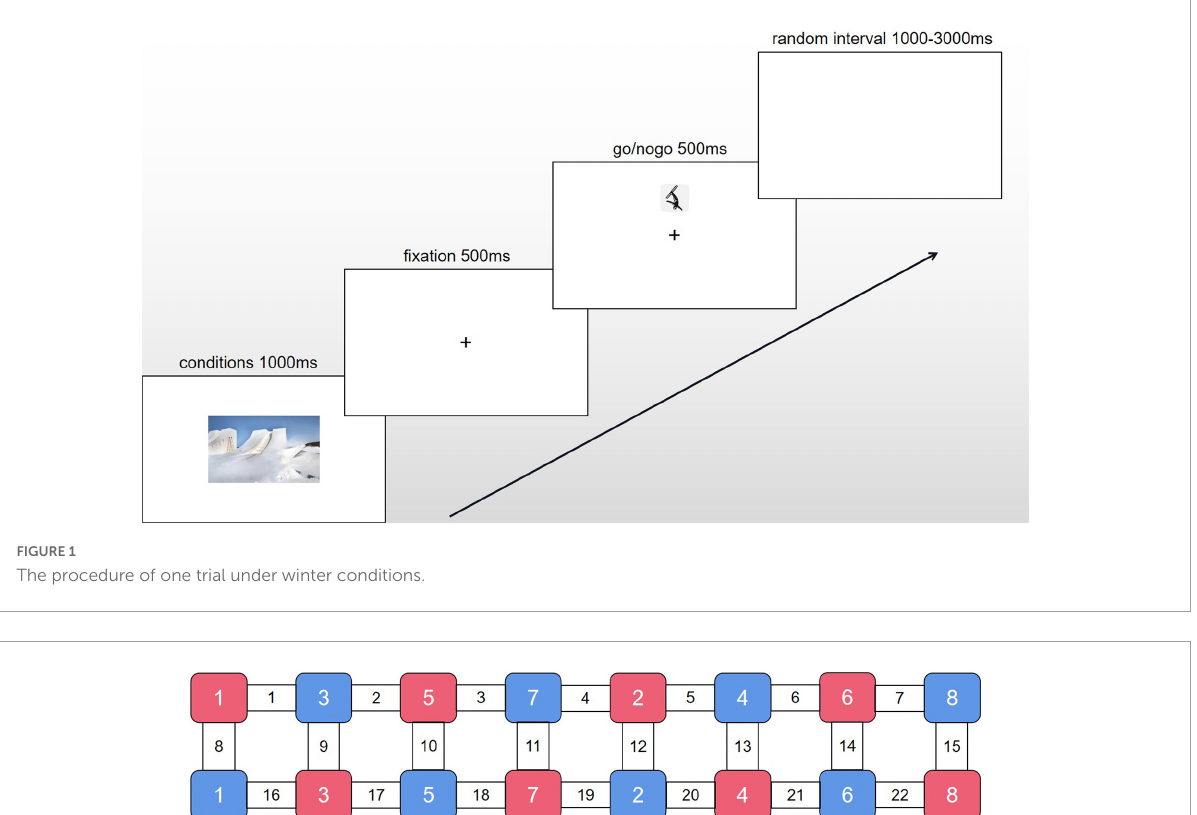
FIGURE2 fNIRS setup. We conduct 2 × 8 optode placement for one subject. The red ones are the emitters, and the blue ones are the detectors. The channels between pairs of emitters and detectors are measured.